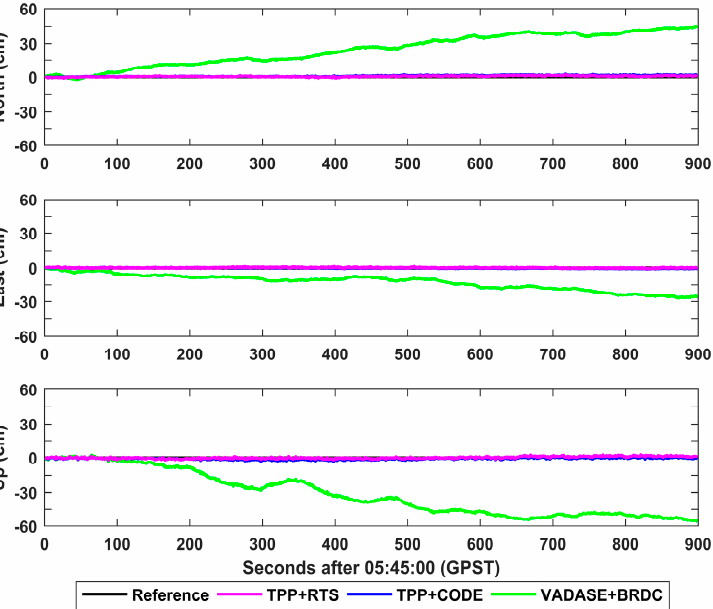
Figure 5. The retrieved displacements in north, east and up components for different schemes at station MIZU.